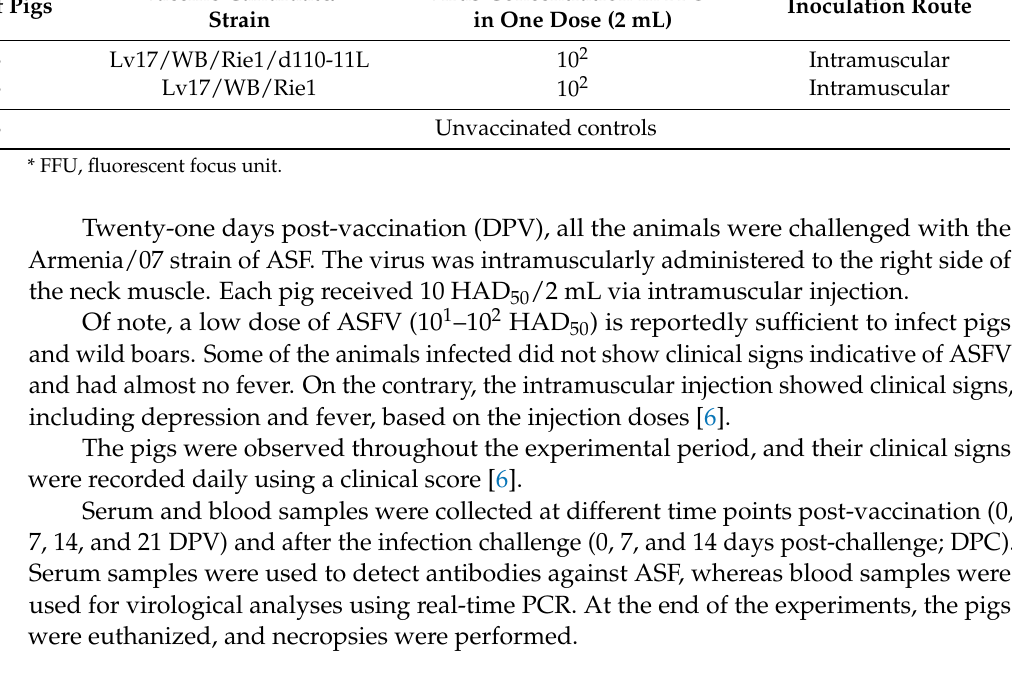
Table 3. African swine fever virus (ASFV) vaccine candidate and ASFV strain used in the experiment. Vaccine Candidate/ Virus Concentration in FFU Group No. of Pigs Strain